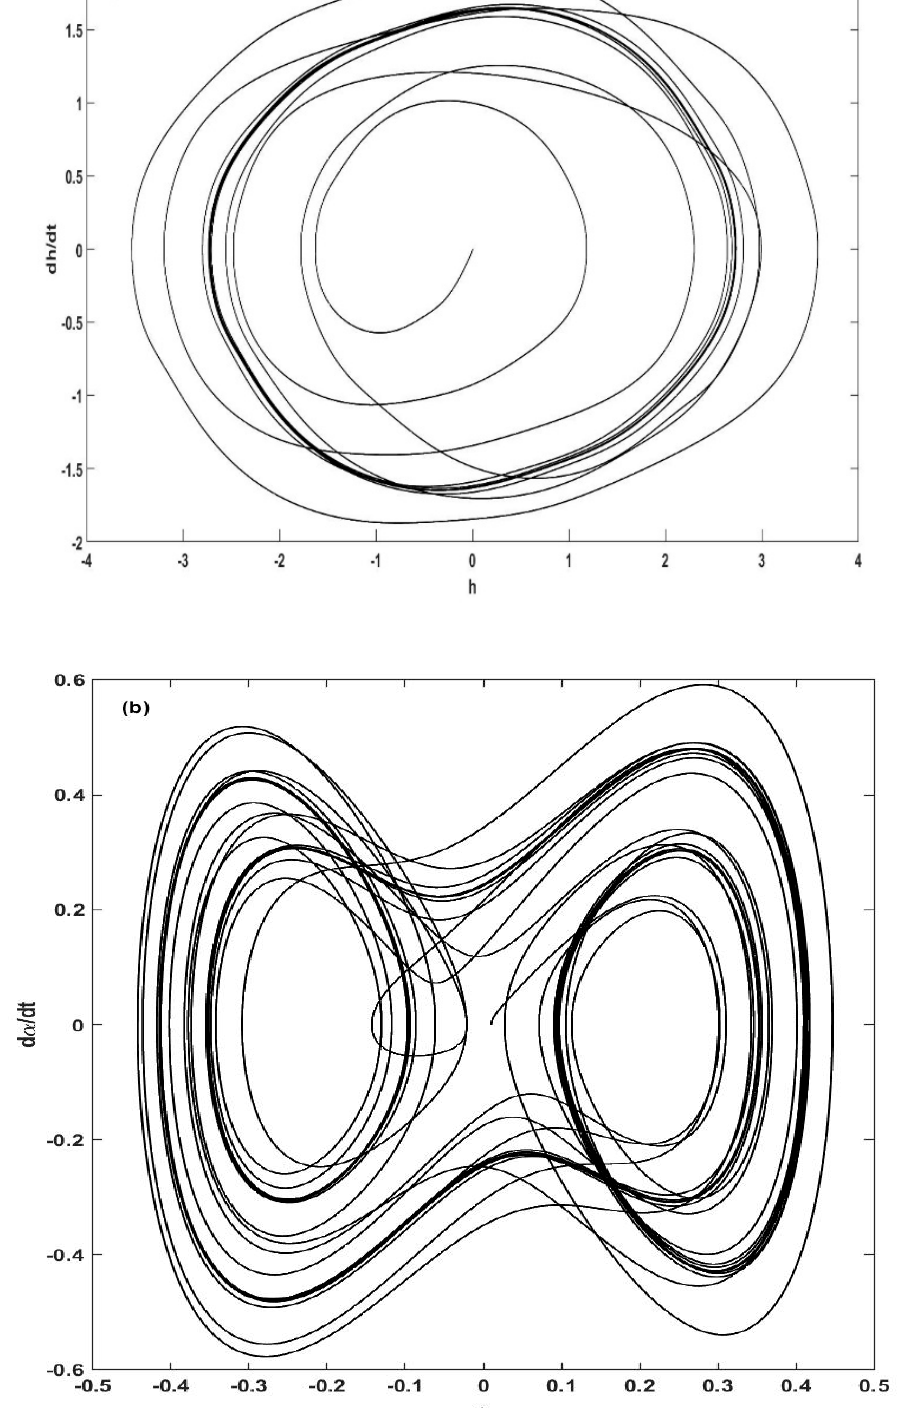
Figure 3. Phase plot depicting the chaotic motion of airfoil (Q = 15.6, e = 20, d = 0.08). ( a ) Phase plot of the bending (h) dof. ( b ) Phase plot of the pitch ( α ) dof.